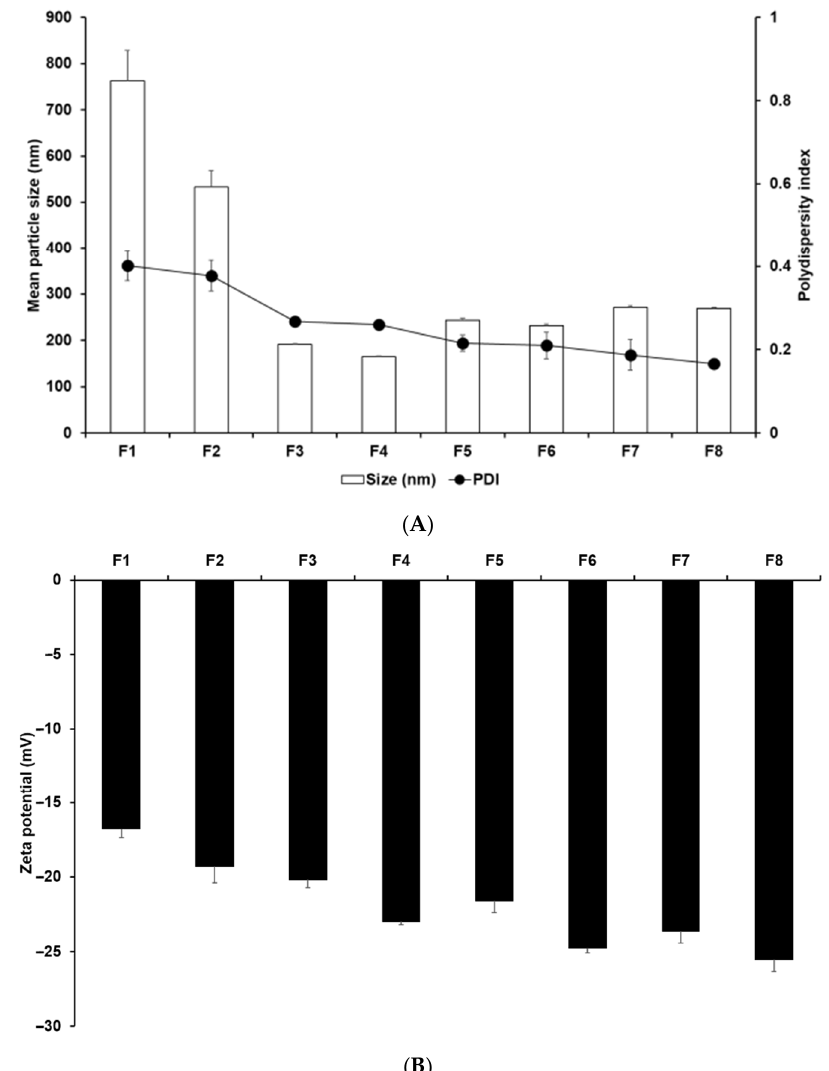
Figure 3. ( A ) Average particle sizes and PDIs and ( B ) zeta potentials of P18-loaded SLNs prepared using different ingredients. Results are expressed as the means ± standard deviations of three independent experiments ( n = 3). PDI, polydispersity index.